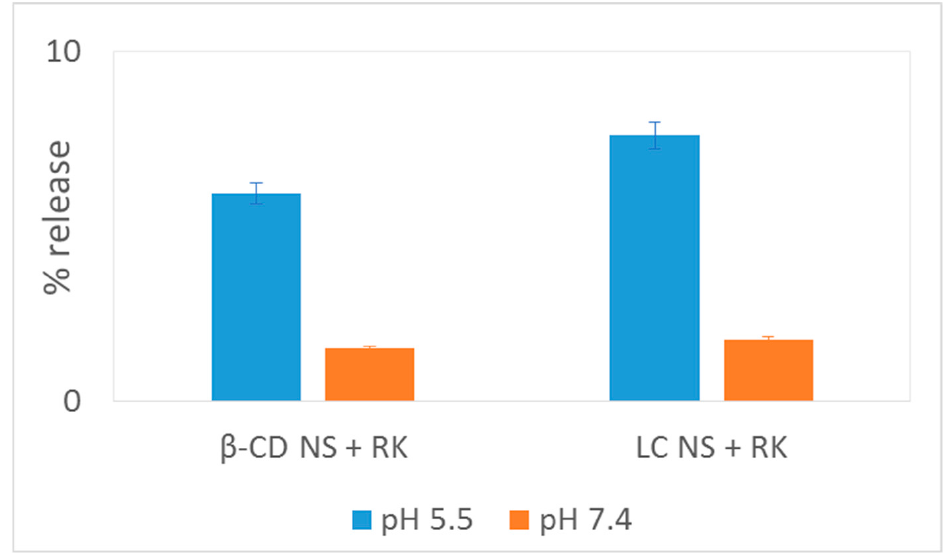
Figure 9. Release of RK-loaded NSs in pH 5.5–7.4 after 28 h.